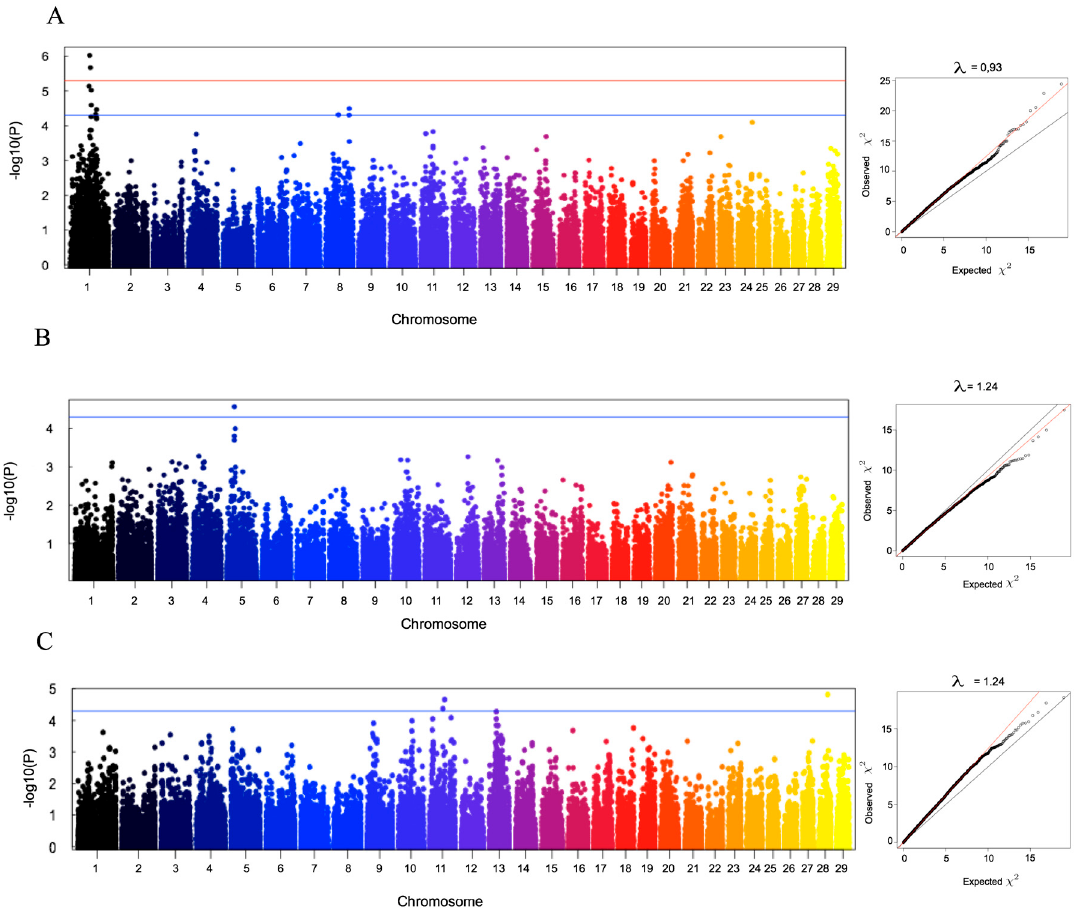
Figure 6. Manhattan plot for single SNP GWAS with correction for population structure. ( A ) Longevity; ( B ) age at first calving; ( C ) direct genetic e ff ect for calf weight at 4 months. The red and blue horizontal lines correspond to genome-wide significant and suggestive thresholds, namely adjusted- p -value = 0.000005 and adjusted- p -value = 0.00005, respectively. Q-Q plots generated to assess the reliability of the detected associations are shown for each analyzed trait along with the corresponding deflation factor ( λ